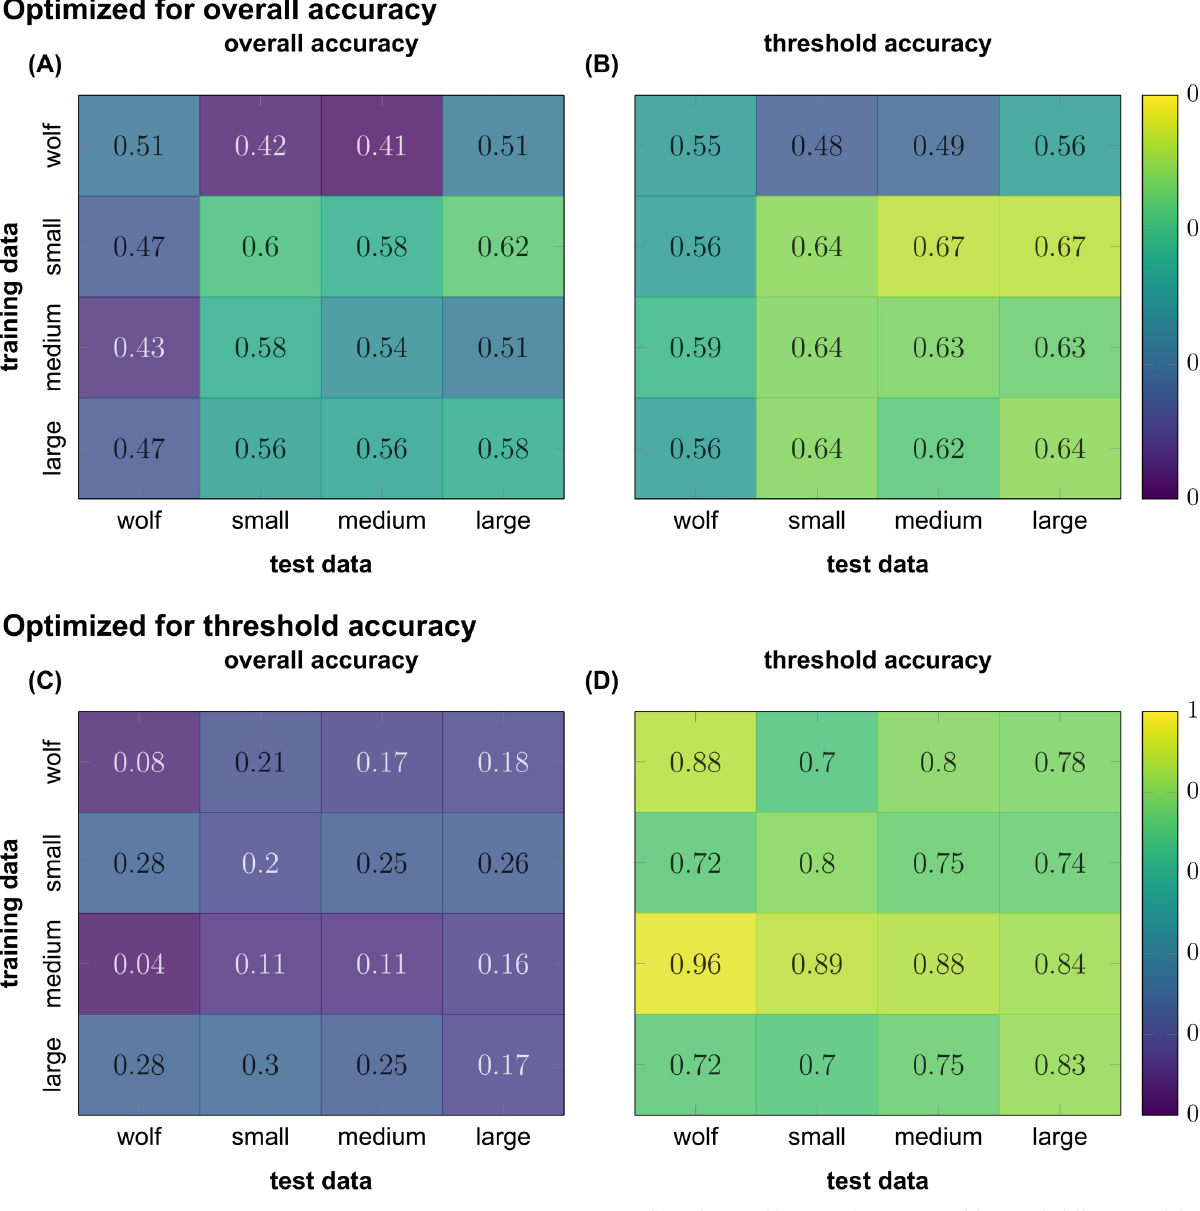
Fig 2. Performance of our models, under different optimization strategies. Small, medium and large are three groups of dogs, with differing sized dogs in them. Panels (A) and (B) show overall and threshold accuracies of models optimized for overall accuracies, while panels (C) and (D) show the same for models optimized for threshold accuracies. Optimizing for threshold accuracy leads to unbalanced models, with lot of true negatives, but few true positives.